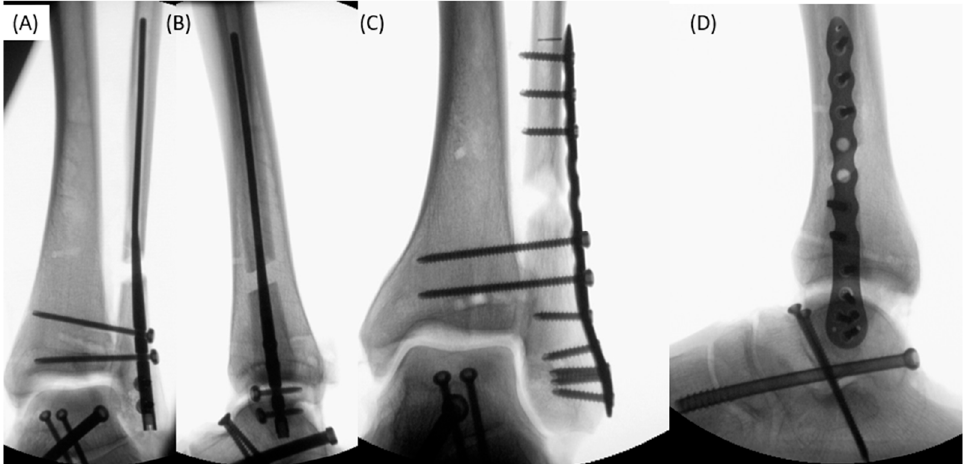
Figure 1. X-ray ( A , B ) fixations with the Vitus-Fi Fibula Nail System (nail group) with two locking and two syndesmotic screws in anterior–posterior and lateral radiographs; X-ray ( C , D ) fixations with locking plate (plate group) with two syndesmotic screws in the anterior–posterior and lateral radiographs. For the fixation, the donors’ left and right specimens were randomized in plate or nail groups to avoid side-specific